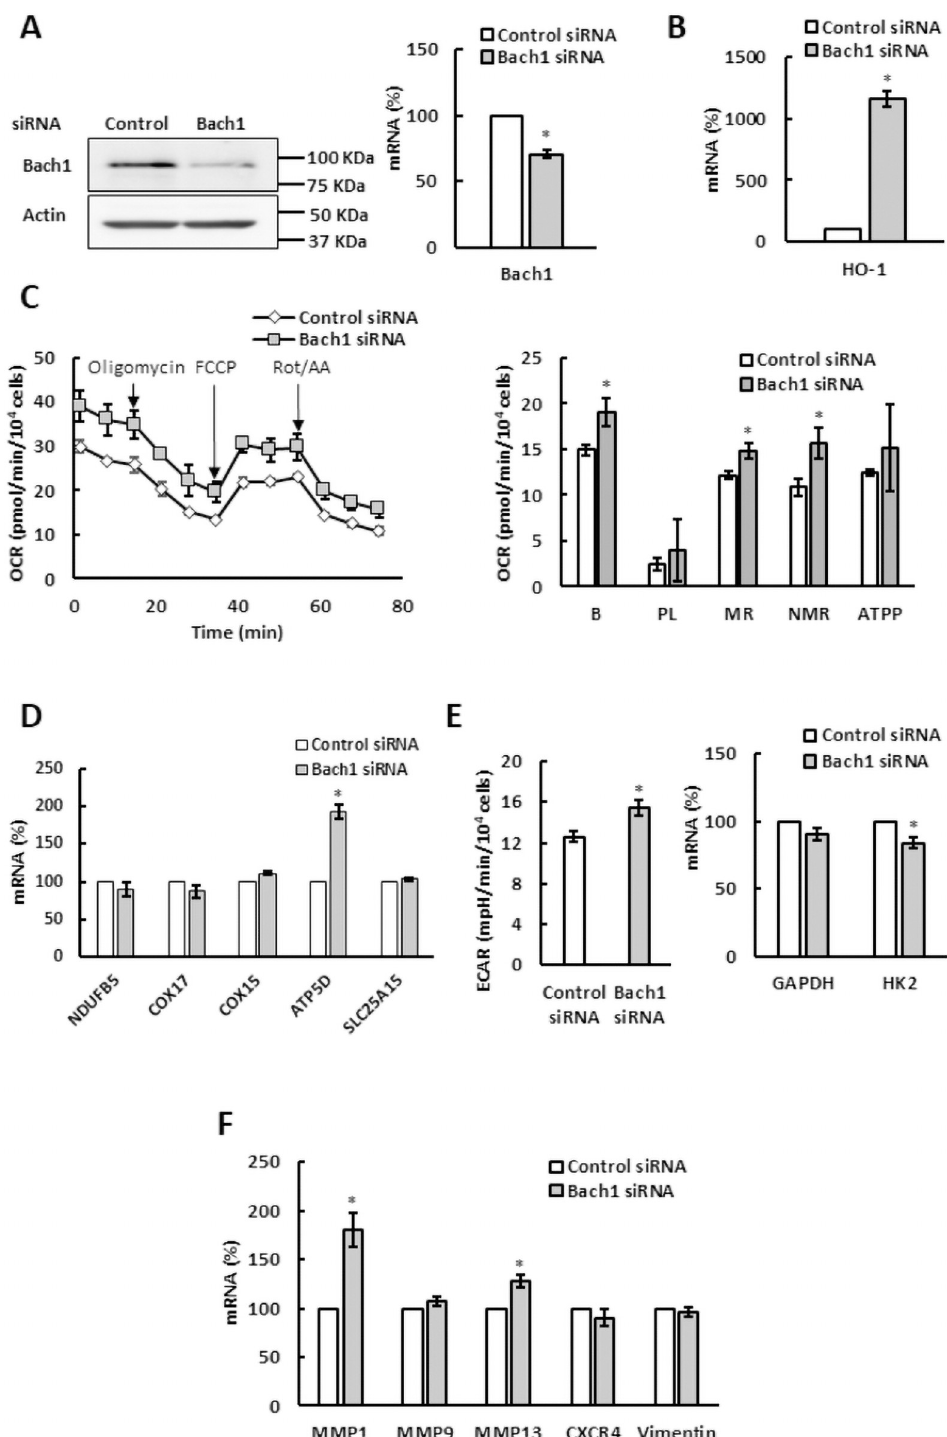
Fig 7. Bach1 regulates mitochondrial respiration in MDA MB 231 cells. MDA MB 231 cells were transfected with Bach1 or control siRNA and analyzed by (A) western blotting using Bach1 and actin antibodies and qRT-PCR. (B) HO-1 mRNA levels, (C) OCR, (D) expression of ETC and OXPHOS genes, (E) ECAR and GAPDH and HK2 mRNA levels, and (F) expression of metastatic genes. (A-F) The experiments were repeated three times, and the numerical results are shown as means ± S.D. Values that are statistically different ( p < 0.05) from the control (MDA MB 231 cells transfected with control siRNA) are indicated by an asterisk. https://doi.org/10.1371/journal.pone.0260400.g007 PLOS ONE | https://doi.org/10.1371/journal.pone.0260400 November22,